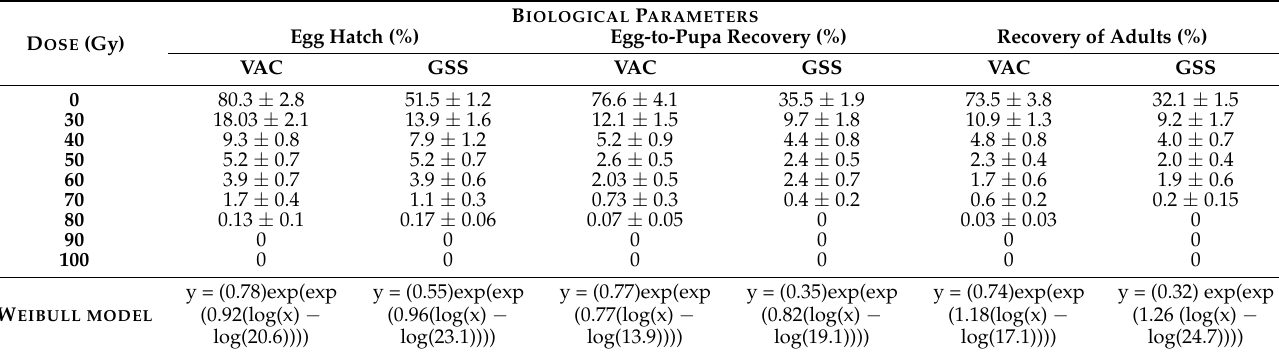
Table 1. Biological parameters (mean ± SE) from crosses between fertile females and irradiated Anastrepha fraterculus males from a bisexual strain (VAC) and a genetic sexing strain (GSS) under hypoxia. D OSE (Gy)